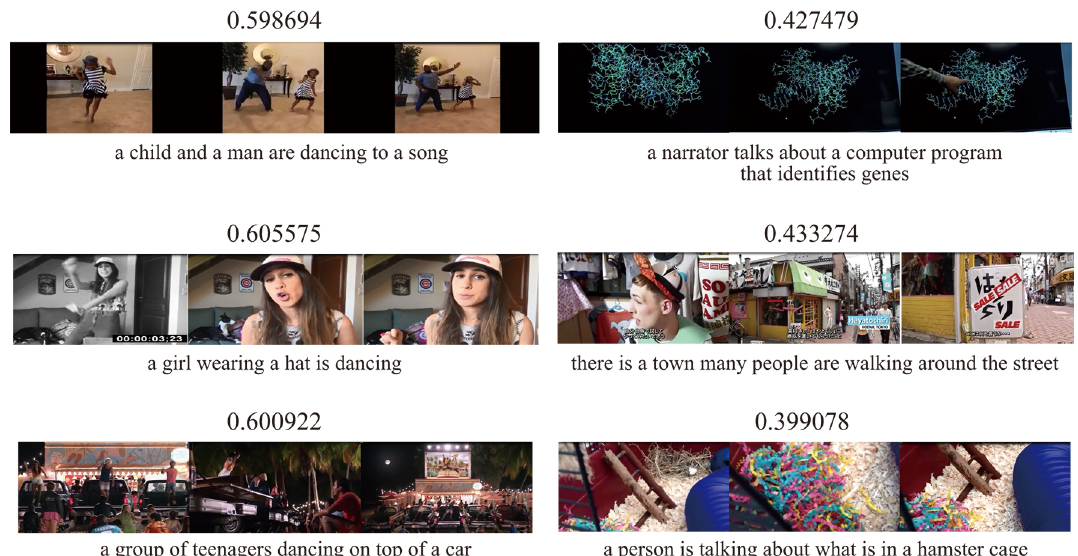
Figure 5. Examples of video and sentence with assigned weight to the global feature. The numbers and the sentences represent the weight for the global feature and query sentences,